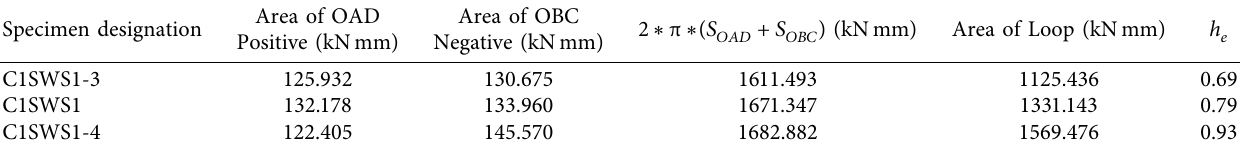
Table 11: Cumulative energy dissipation and viscous damping ratio for grade of